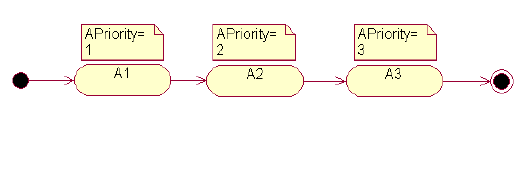
Fig. 5. Assigning APriority tag value for a simple activity diagram